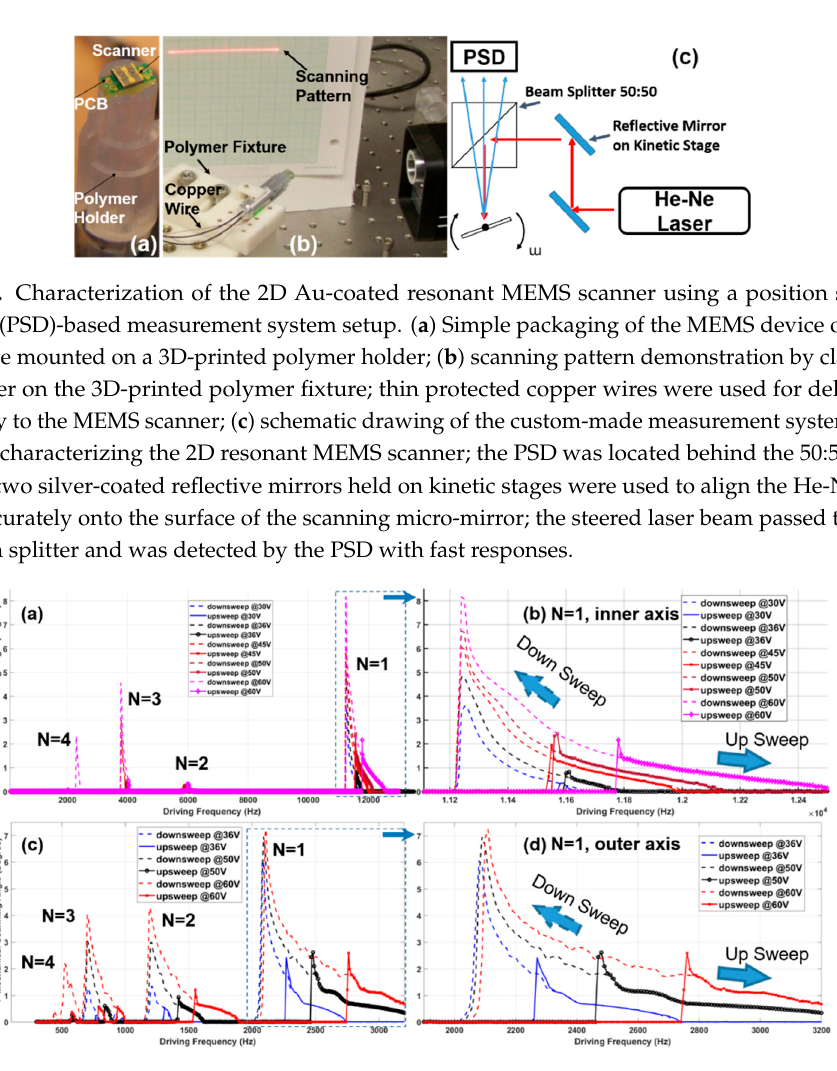
Figure 7. Characterization of the parametrically-resonant scanner on both inner (fast) and outer (slow) axes. ( a ) Tilting amplitude (mechanical scanning angle (MSA), units: degrees) vs. driving frequency sweeping (from 1 Hz–13k Hz, in ambient air, with variant driving voltage from 30 V–60 V) of the inner (fast) axis (N = 1–4); ( b ) zoom-in view of the response curves of the inner (fast) axis while N = 1; ( c ) tilting amplitude vs. driving frequency sweeping (from 1 Hz–3500 Hz) of the outer (slow) axis (N = 1–4, in the ambient air at room temperature, with variant driving voltage from 36 V–60 V); ( d ) zoom-in view of the response curves of the outer axis for N = 1. Note: while N = 1, the driving frequency is double the resonant scan